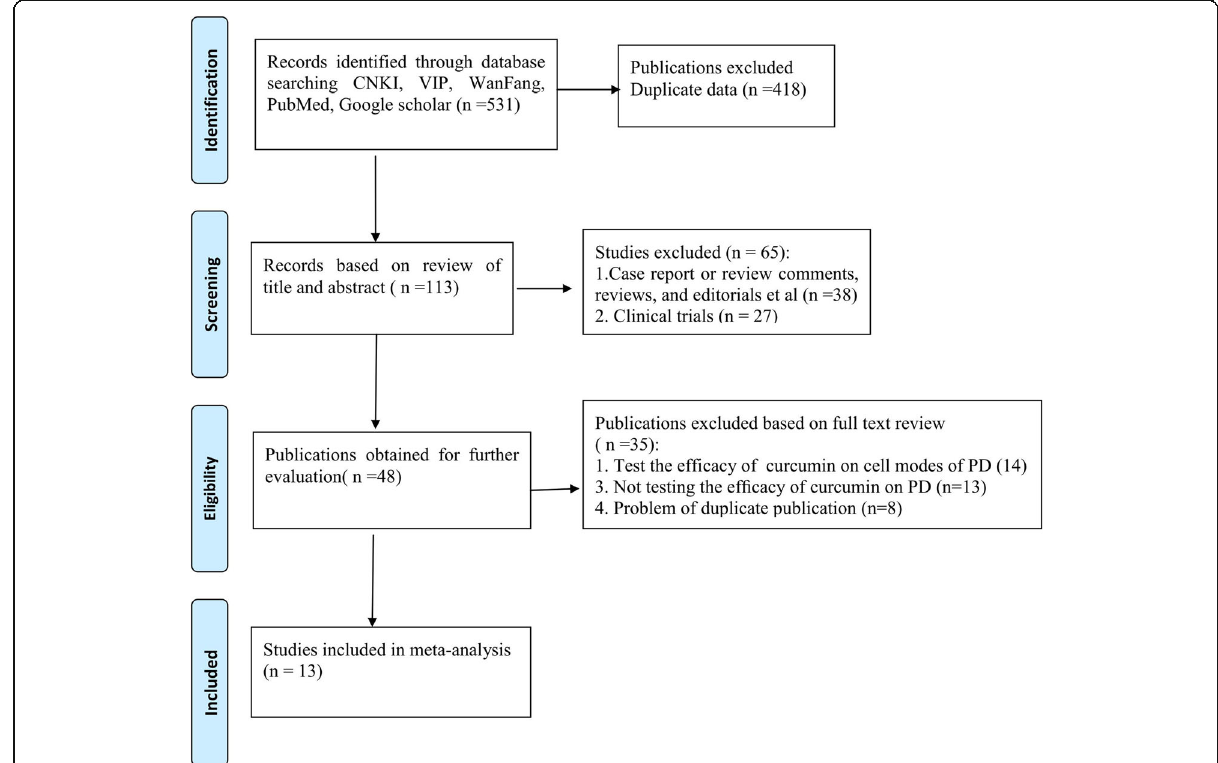
Fig. 1 Algorithm of study selection and inclusion in the